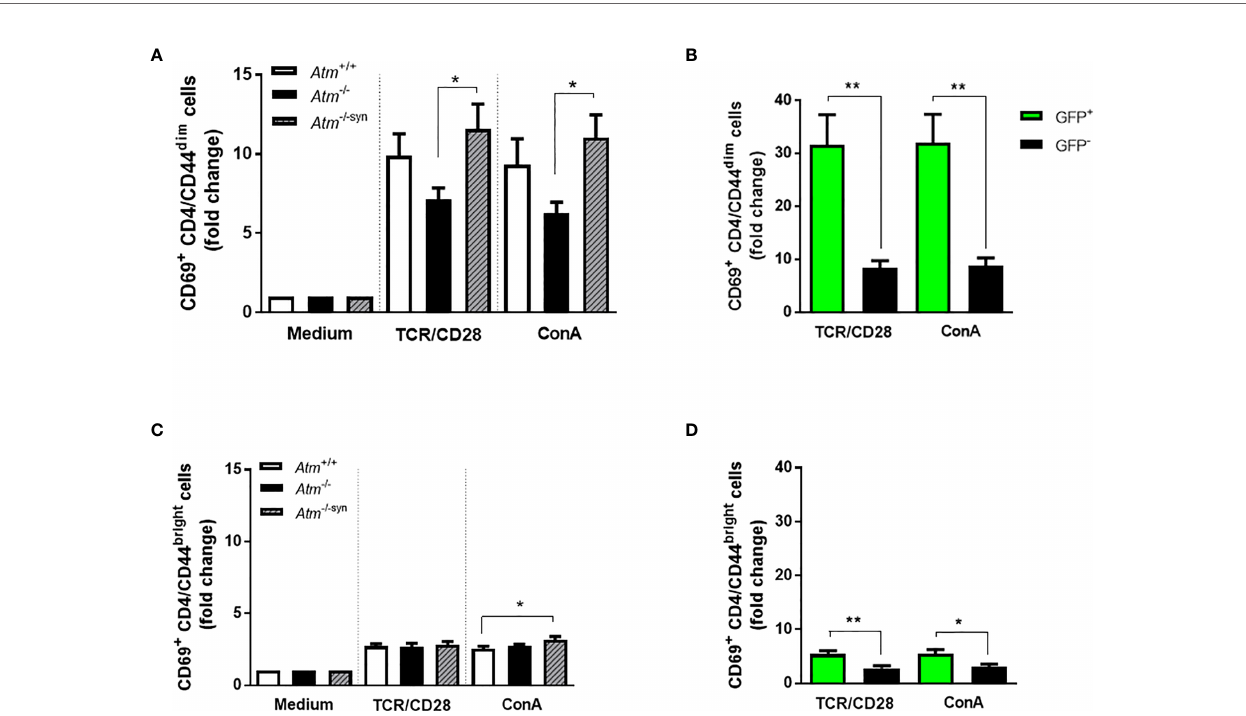
FIGURE 5 | Activation of T-cell subpopulations in splenocytes of Atm -de fi cient mice in vitro using fl ow cytometry. (A) Expression of CD69 + in TCR- and ConA- stimulated CD4 + /CD44 dim splenocytes from untreated Atm +/+ , Atm -/- and transplanted Atm -/-syn mice 12 weeks after HSCT (n > 6). The data were normalized to the unstimulated medium control. (B) Expression of CD69 + in GFP + and GFP - CD4 + /CD44 dim splenocytes stimulated either via TCR or ConA isolated from Atm -/-syn mice 12 weeks after HSCT (n = 6). (C) T-cell activation in CD4 + /CD44 bright splenocytes stimulated with either a CD3 and a CD28 or ConA from Atm +/+ , Atm -/- , and Atm -/-syn mice (12 weeks after HSCT) (n > 6). The data were normalized to the medium control. (D) Flow cytometric analysis of CD69 + expression GFP + and GFP - CD4 + / CD44 bright splenocytes isolated from Atm -/-syn mice either stimulated via TCR or ConA 12 weeks after HSCT (n = 6). Data are presented as mean ± SEM. * p < 0.05, ** p < 0.01. ConA, Concanavalin A; GFP, green fl uorescent protein; HSCT, hematopoietic stem cell transplantation; TCR, T cell